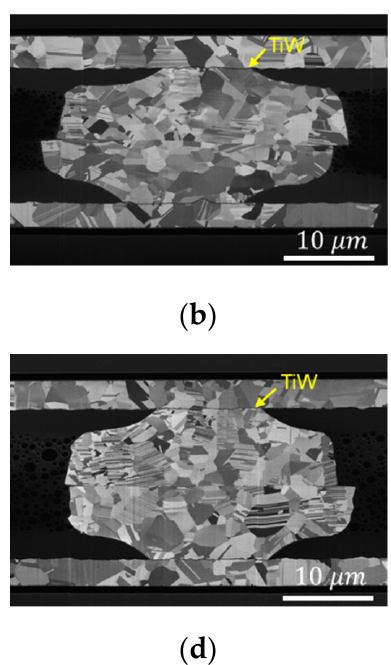
Figure 2. The cross-sectional images of as-fabricated Cu–Cu bumps. ( a ) Electron image and ( b ) ion image of 300 ◦ C/90 MPa/30 s. ( c ) Electron image and ( d ) ion image of 300 ◦ C/31 MPa/10 s.